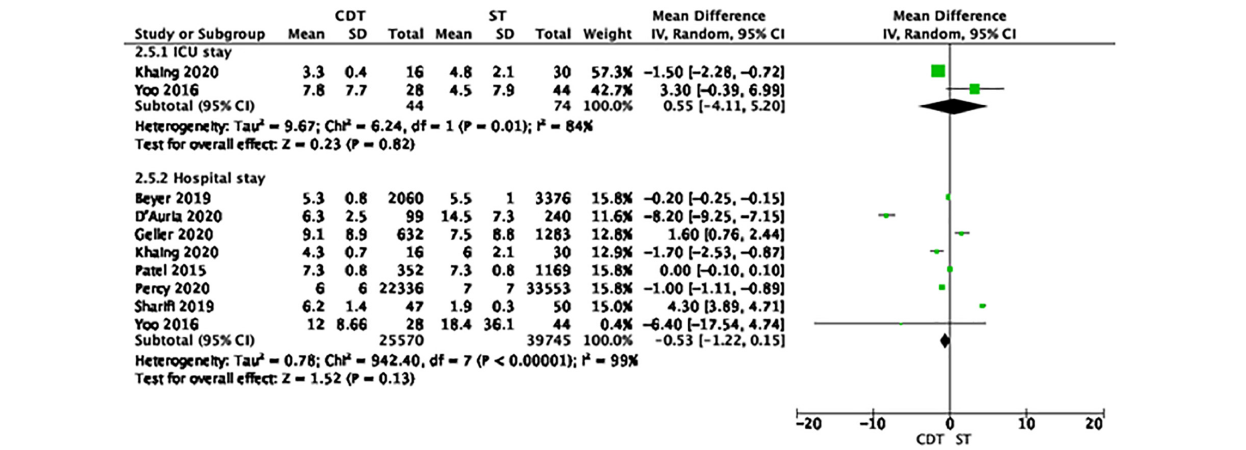
FIGURE 2 | Forest plot of length of hospital stay in the catheter-directed therapies (CDT) group and systemic thrombolysis (ST). Each green rectangle or square represents an individual study, with 95% confidence intervals of the result displayed as black horizontal lines. The diamonds show the result when all the individual studies are combined together and